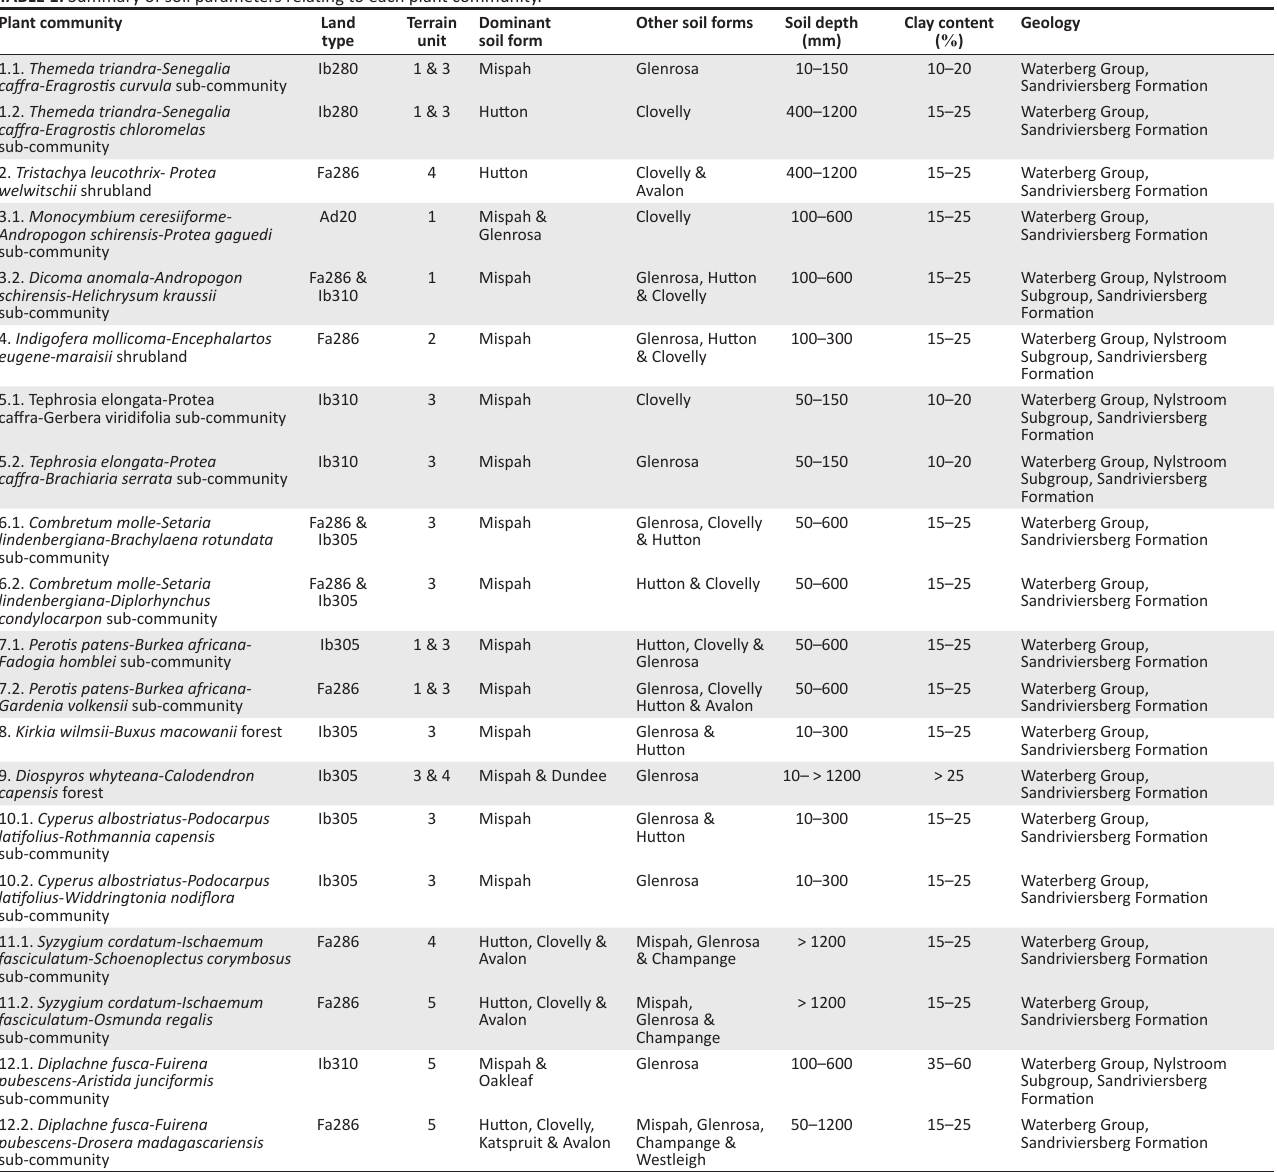
TABLE 1: Summary of soil parameters relating to each plant community. Plant